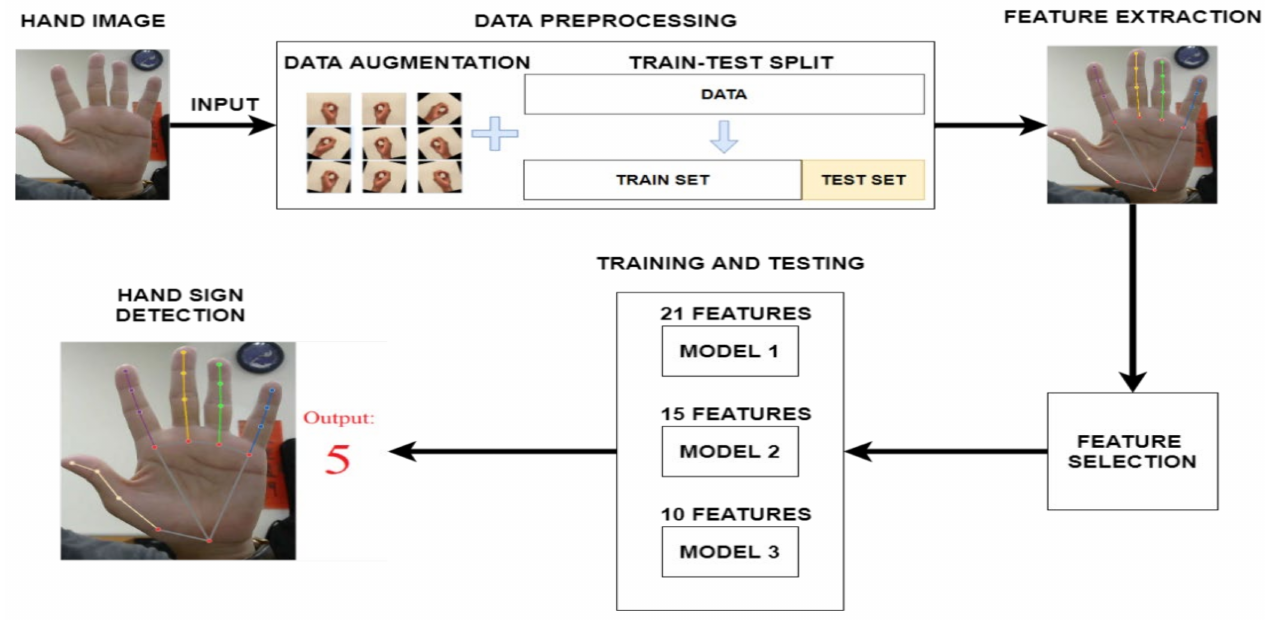
Figure 1. The general research design.